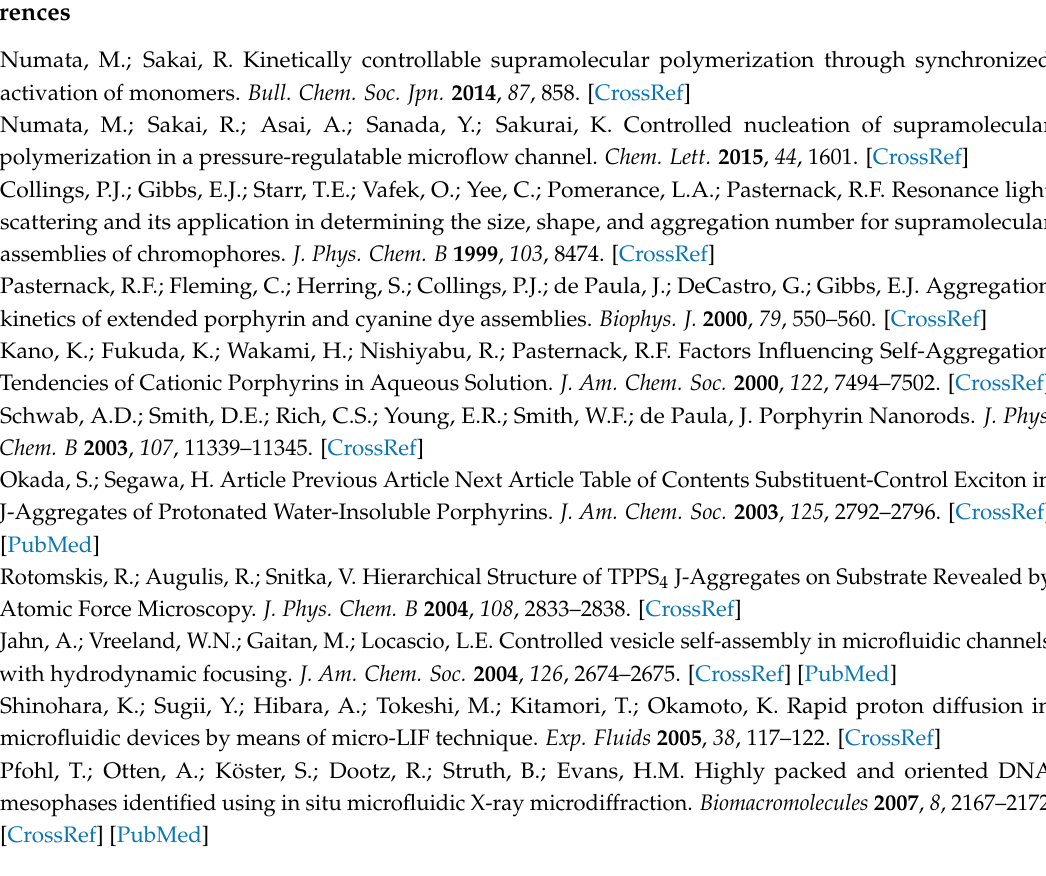
Figure S1: Total aggregation efficiency upon changing the flow rate (including both pressure and diffusion effects; blue dots) and extracted pressure effects under constant proton diffusion effect at 10 µ L/min (red dots); (a) pH 5; (b) pH 3; Figure S2: UV–Vis spectral changes of TPPS upon changing the pressure inside the channel at pH 5; v = (a) 10, (b) 25, and (c) 50 µ L/min. 0.1 mm cell, r.t; Figure S3: Effects of proton diffusion time on aggregation efficiency upon changing the back-pressure inside the channel; summary of extracted pressure effects on aggregation efficiency; Figure S4: Effects of proton diffusion time on aggregation efficiency in turbulent